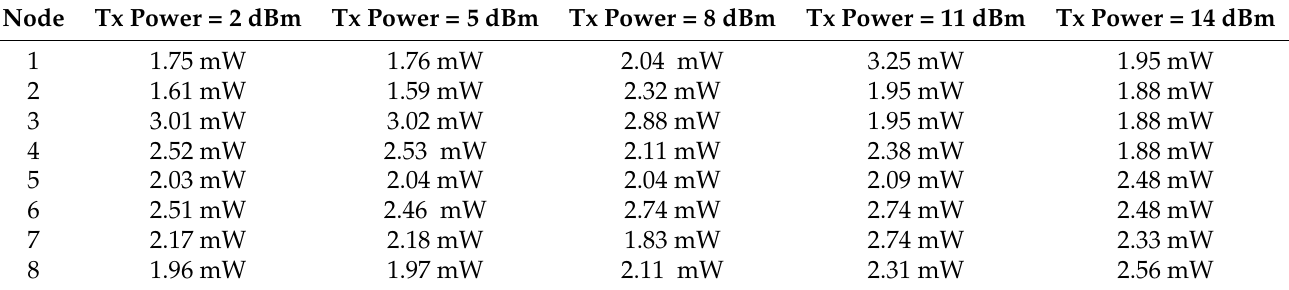
Table 6. Energy consumption of nodes